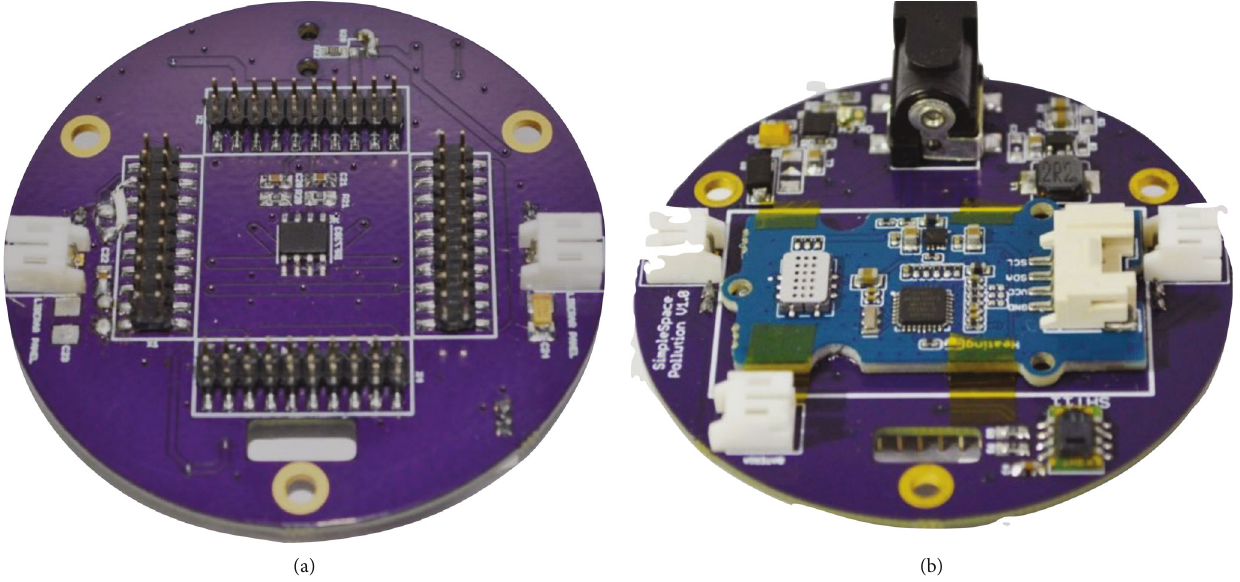
Figure 4: SimplePower and SimplePollution both in the same board interface, top (a) and bottom